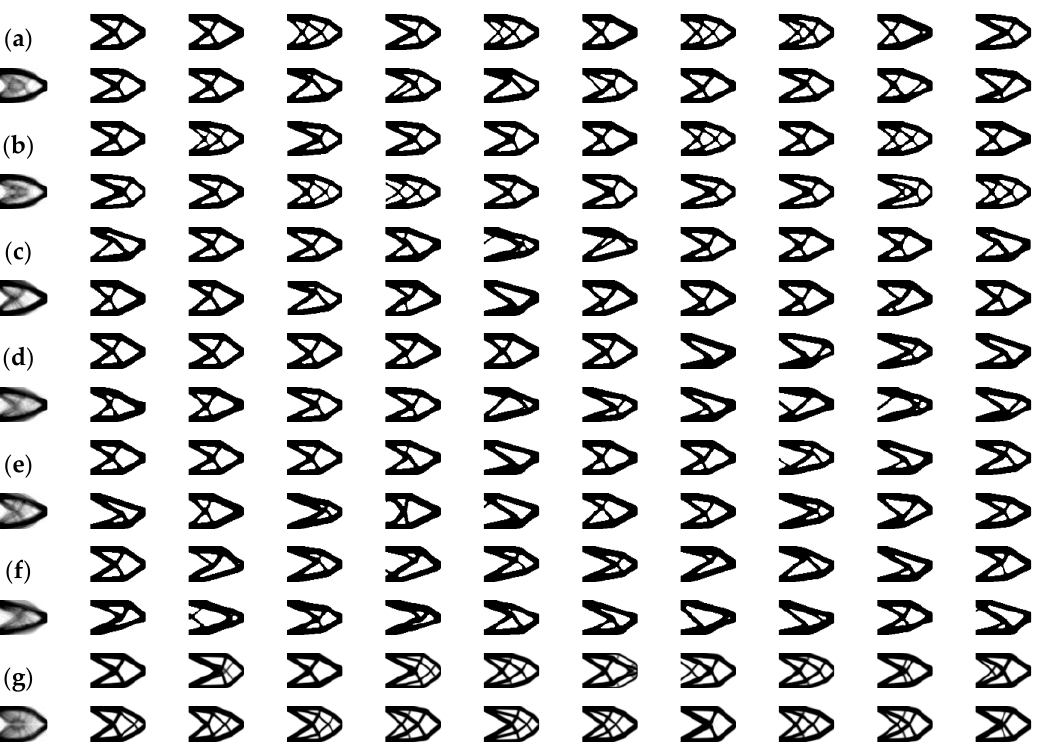
Figure 6. Generated options and stacked views of the cantilever beam by ( a ) decaying 𝜀 -greedy policy, ( b ) UCB algorithm with BESO, ( c ) TS method with beta distribution, ( d ) TS method with Gaussian distribution, ( e ) VIDS method with beta distribution, ( f ) IDS method with Gaussian distribution and ( g ) UCB algorithm with SIMP.